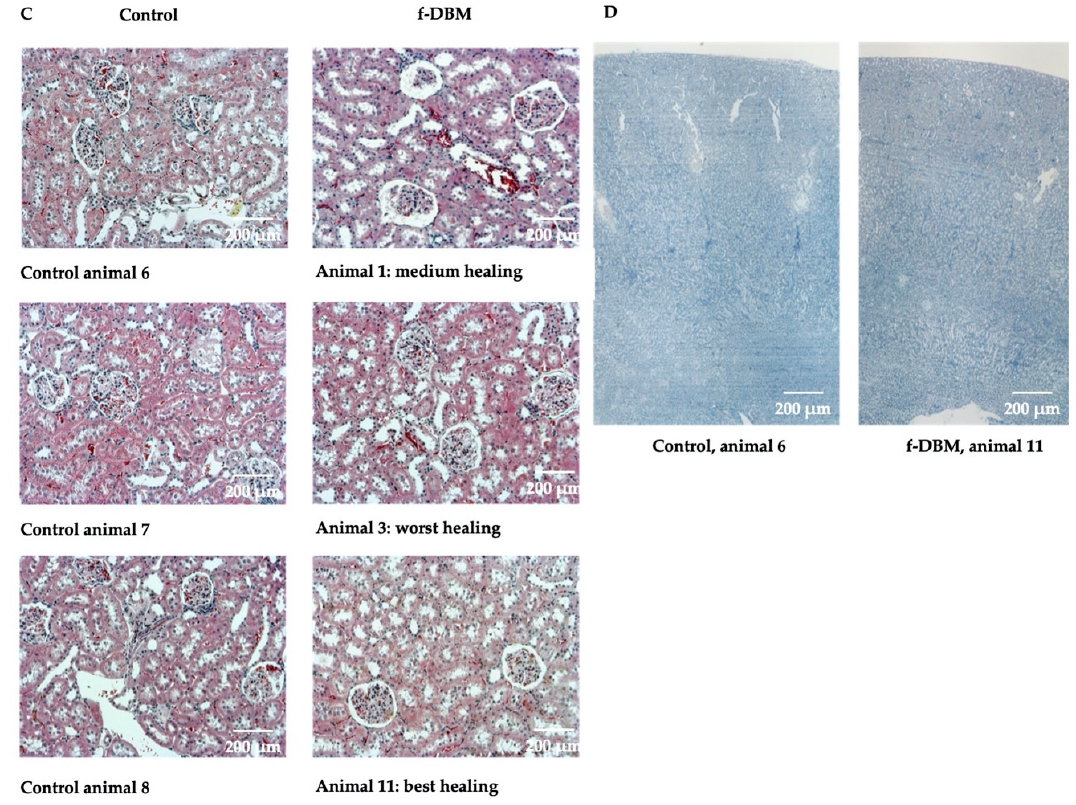
Figure 4. Histology of liver and kidney of all animals, that underwent surgery and untreated control. Histological analysis of the liver. ( A ) HE staining, organs of three control animals (left column) and three operated animals with di ff erent healing progressions (right column) are shown. In ( B ), chloroacetate esterase (CAE)-stained liver preparations from a control animal (top) and an operated animal (bottom) are shown. Yellow arrows mark leukocytes grouped around a blood vessel. This was equally common in both groups. In general, no correlation was observed between the healing process and the fine structure of the liver or leukocyte infiltration. Histological analysis of the kidney. ( C ) HE staining, organs of three control animals (left column) and three operated animals with di ff erent healing progressions (right column) are shown. In ( D ), CAE-stained kidney preparations from a control animal (left) and an operated animal (right) are shown. There was no leukocyte infiltration in any of the groups. In general, no correlation was observed between the healing process and the fine structure of the kidney or leukocyte infiltration.